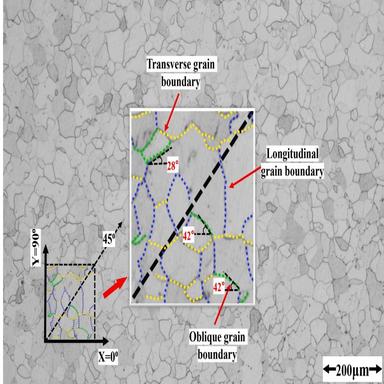
Grain boundary orientation of the ferrite microstructure with grain size of 57 μm.